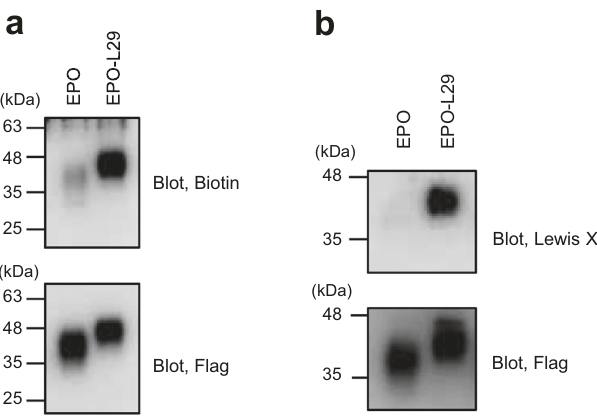
Fig. 5 Interaction of FUT9 with EPO dependent upon the L29 sequence. a Proximity-dependent biotinylation of EPO tagged with the L29 sequence by co-expressed FUT9-TurboID in CHO-K1 cells. After proximity labeling, the 3xFlag-tagged EPO glycoproteins with or without L29 sequence (EPO or EPO-L29, respectively) were puri fi ed using an anti-Flag M2 Af fi nity Gel. The puri fi ed proteins were detected using avidin-HRP and anti-Flag M2 antibody. b FUT9-catalyzed Lewis X formation of desialylated EPO under cell-free conditions. After con fi rming their full desialylation (Supplementary Fig. 6), the 3xFlag-tagged EPO with or without the L29 sequence (EPO or EPO-L29, respectively) were incubated with FUT9. The reaction mixtures were subjected to immunoblot analysis using anti-Lewis X and anti-Flag (N-domain 1-194, C-domain 1-29 directly joined to 217-377) were produced by the ampli fi cation of coding sequence, followed by the insertion at the NotI/AscI sites of mammalian LAMP2-bio-His (Addgene; 51861) 31 . The DNA fragments coding for chimeric mutants of LAMP-1 were purchased from Fasmac Co. Ltd and cloned